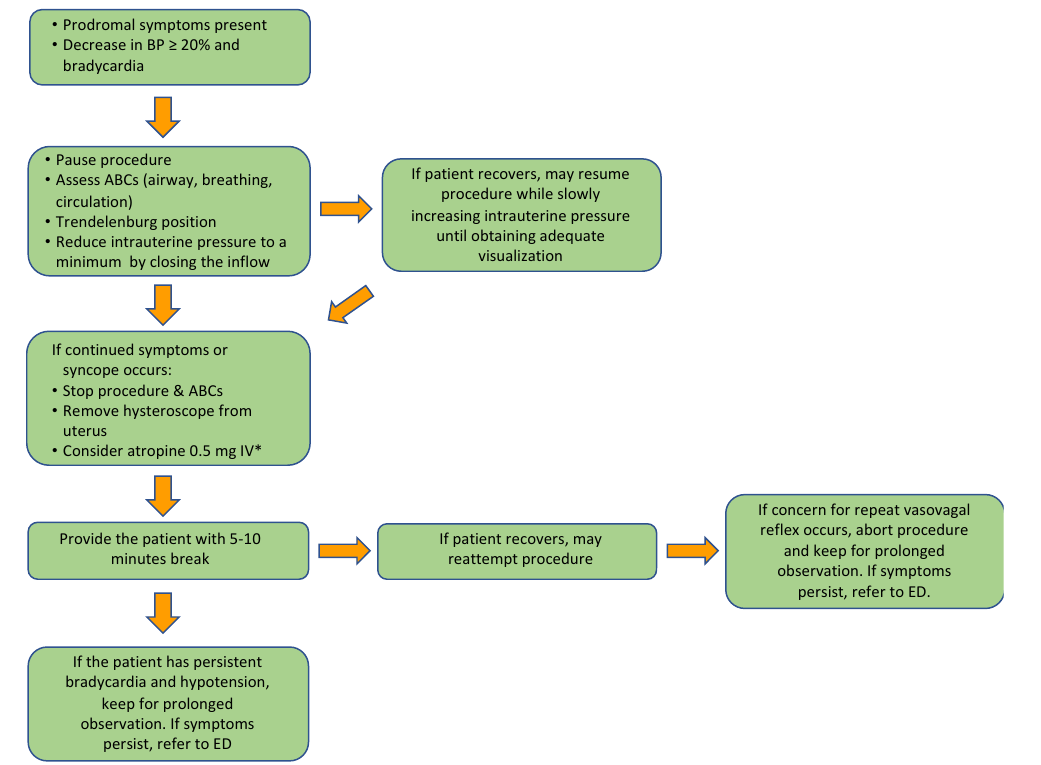
Figure 1. Proposed algorithm for acute management of vasovagal reaction and syncope during office hysteroscopy. * Dosing of atropine: 0.5 mg IV every 3 – 5 min, with maximum dose of 3 mg.